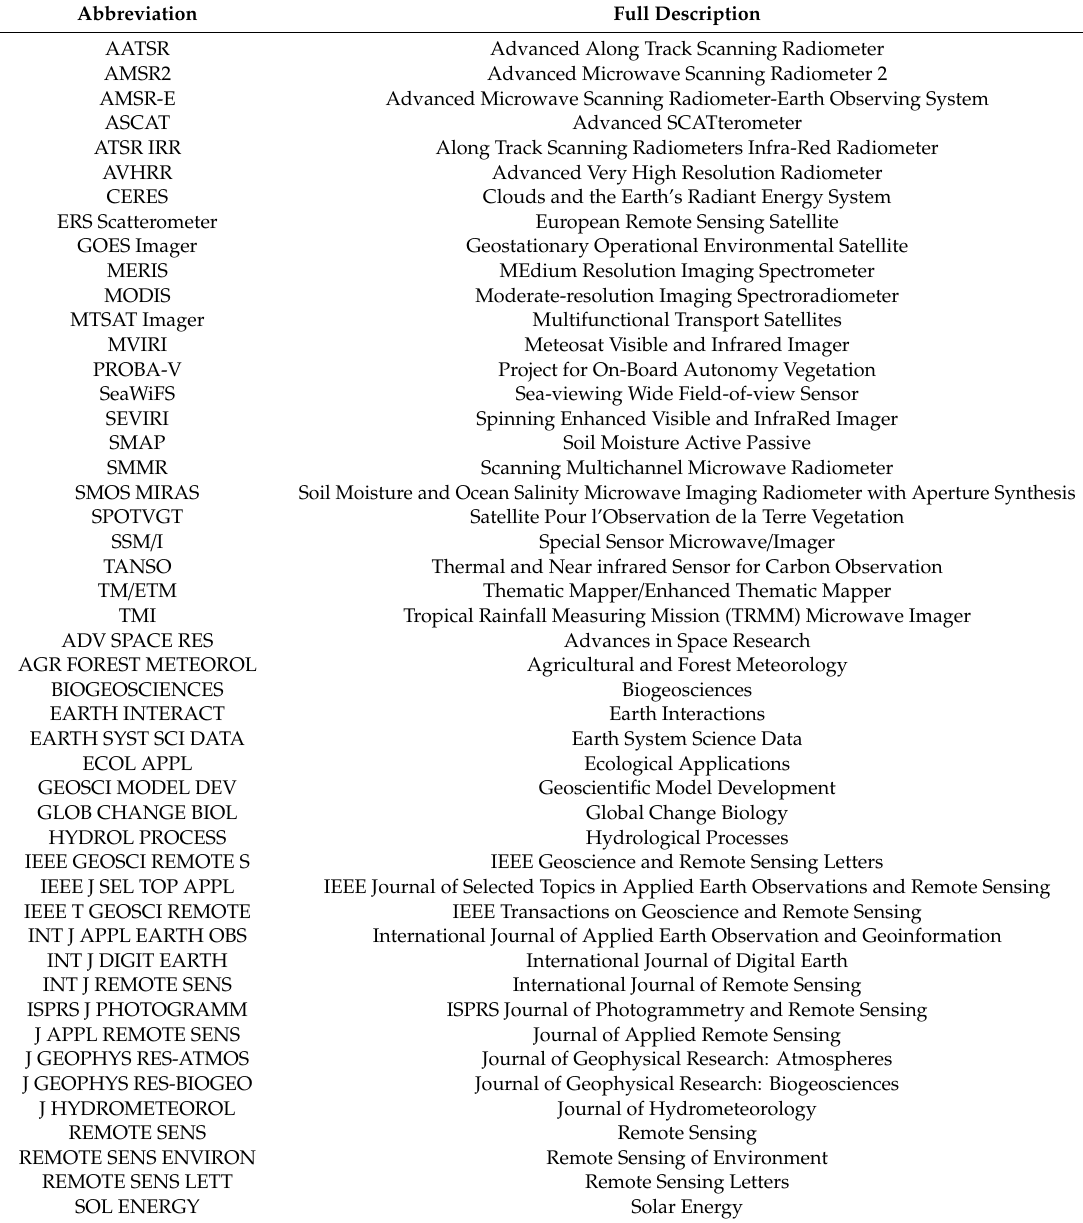
Table A1. Abbreviations of sensors and